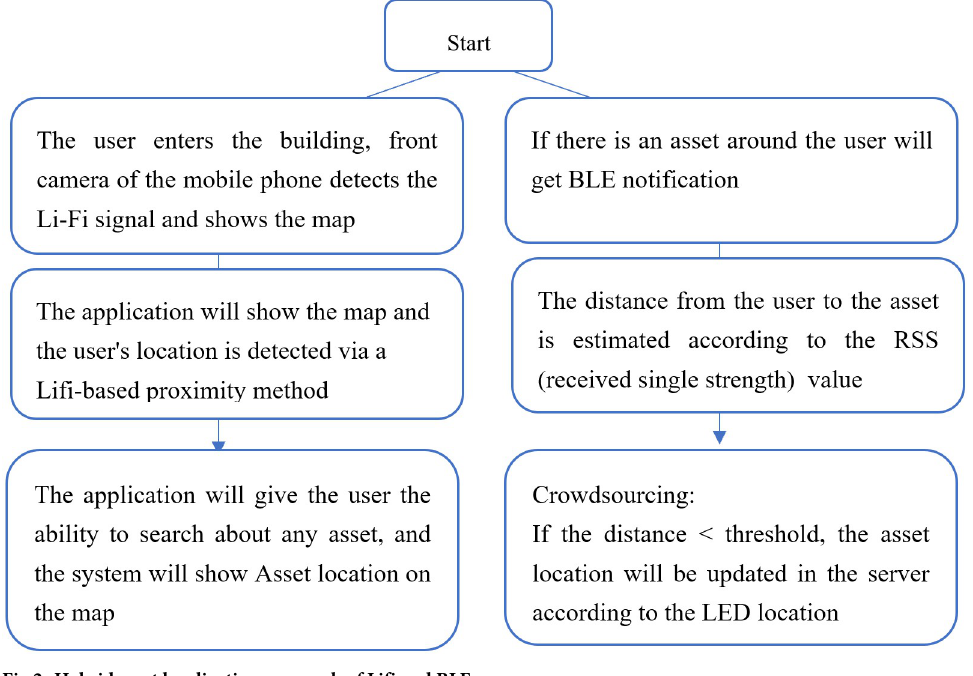
Fig 2. Hybrid asset localization approach of Lifi and